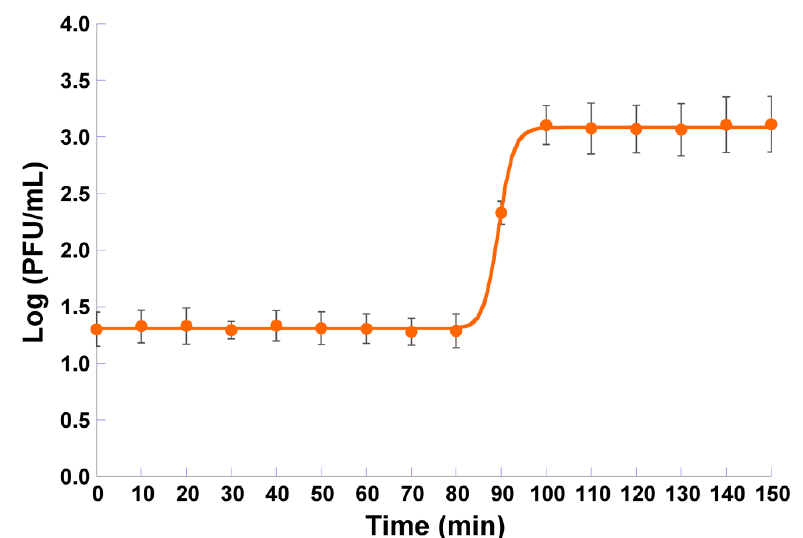
Figure 4. One-step growth curve of phage φ 6 in the presence of P. syringae pv. syringae as the host. Values represent the mean of three experiments; Error bars represent the standard deviation.